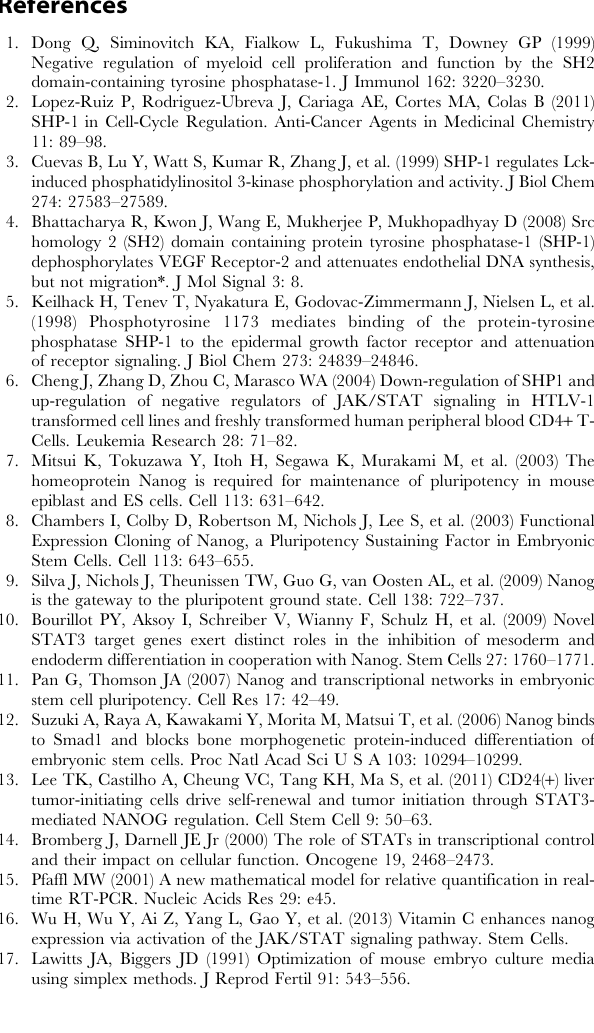
Table S3 Sequences of primers for Nanog promoters. Restriction sites were underlined. Table S4 Sequences of primers for ChIP*-qPCR. *Chro- matin